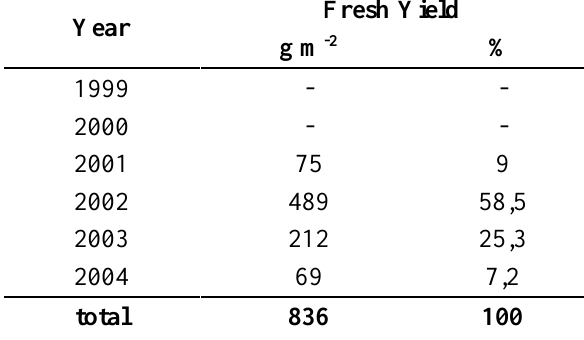
(Figure 1). Its distribution